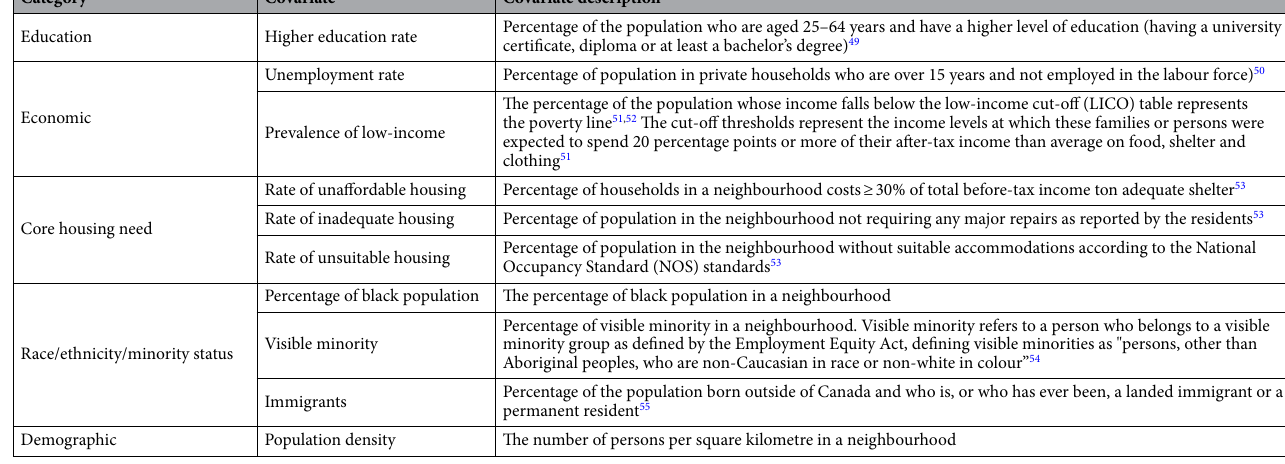
Table 1. Descriptions of the demographic and socioeconomic covariates (2016